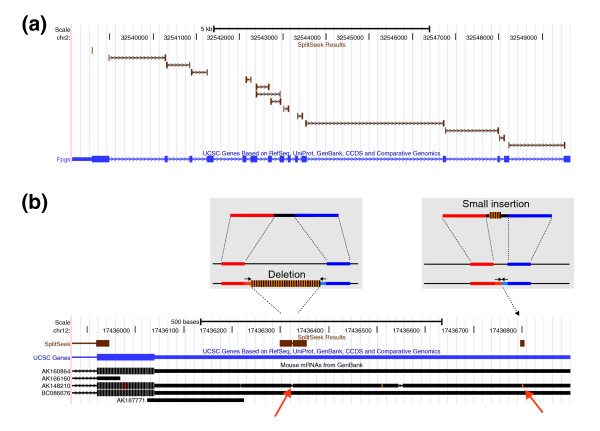
SplitSeek results viewed in the UCSC genome browser. (a) Predicted splice junctions in the gene Fpgs. (b) The two grey boxes give a schematic view of how deletions and insertions are detected. The genome browser image below shows the SplitSeek results in the last exon and 3' UTR of the Nol10 gene on chromosome 12. Three events are predicted, a splice junction (to the left), a deletion (in the middle,) and an insertion (to the right). The predicted insertion and deletion are both supported by the mRNA AK148210, as indicated by the orange arrows at the bottom.